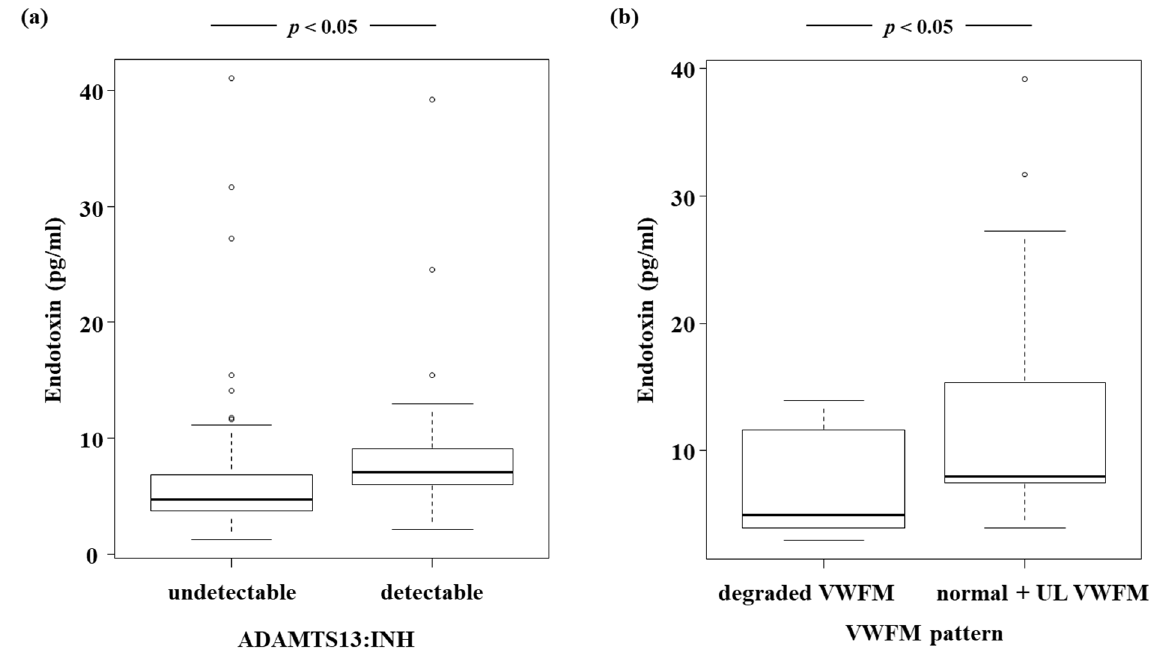
Figure 6. Relationship between endotoxin levels and ADAMTS13:INH and between endotoxin levels and VWFM patterns. ( a ) Patients with detectable ADAMTS13:INH had higher endotoxin levels than those with undetectable ADAMTS13:INH ( p < 0.05). ( b ) Patients with normal and UL VWFM patterns had higher endotoxin levels than those with degraded VWFM ( p < 0.05). Box plots represent, from top to bottom, sample maximum, upper-quartile range, median and lower-quartile range, and sample minimum. ADAMTS13, a disintegrin-like and metalloproteinase with thrombospondin type 1 motifs 13; ADAMTS13:INH, ADAMTS13 inhibitor; VWF, von Willebrand factor; VWFM, VWF multimer; UL, unusually